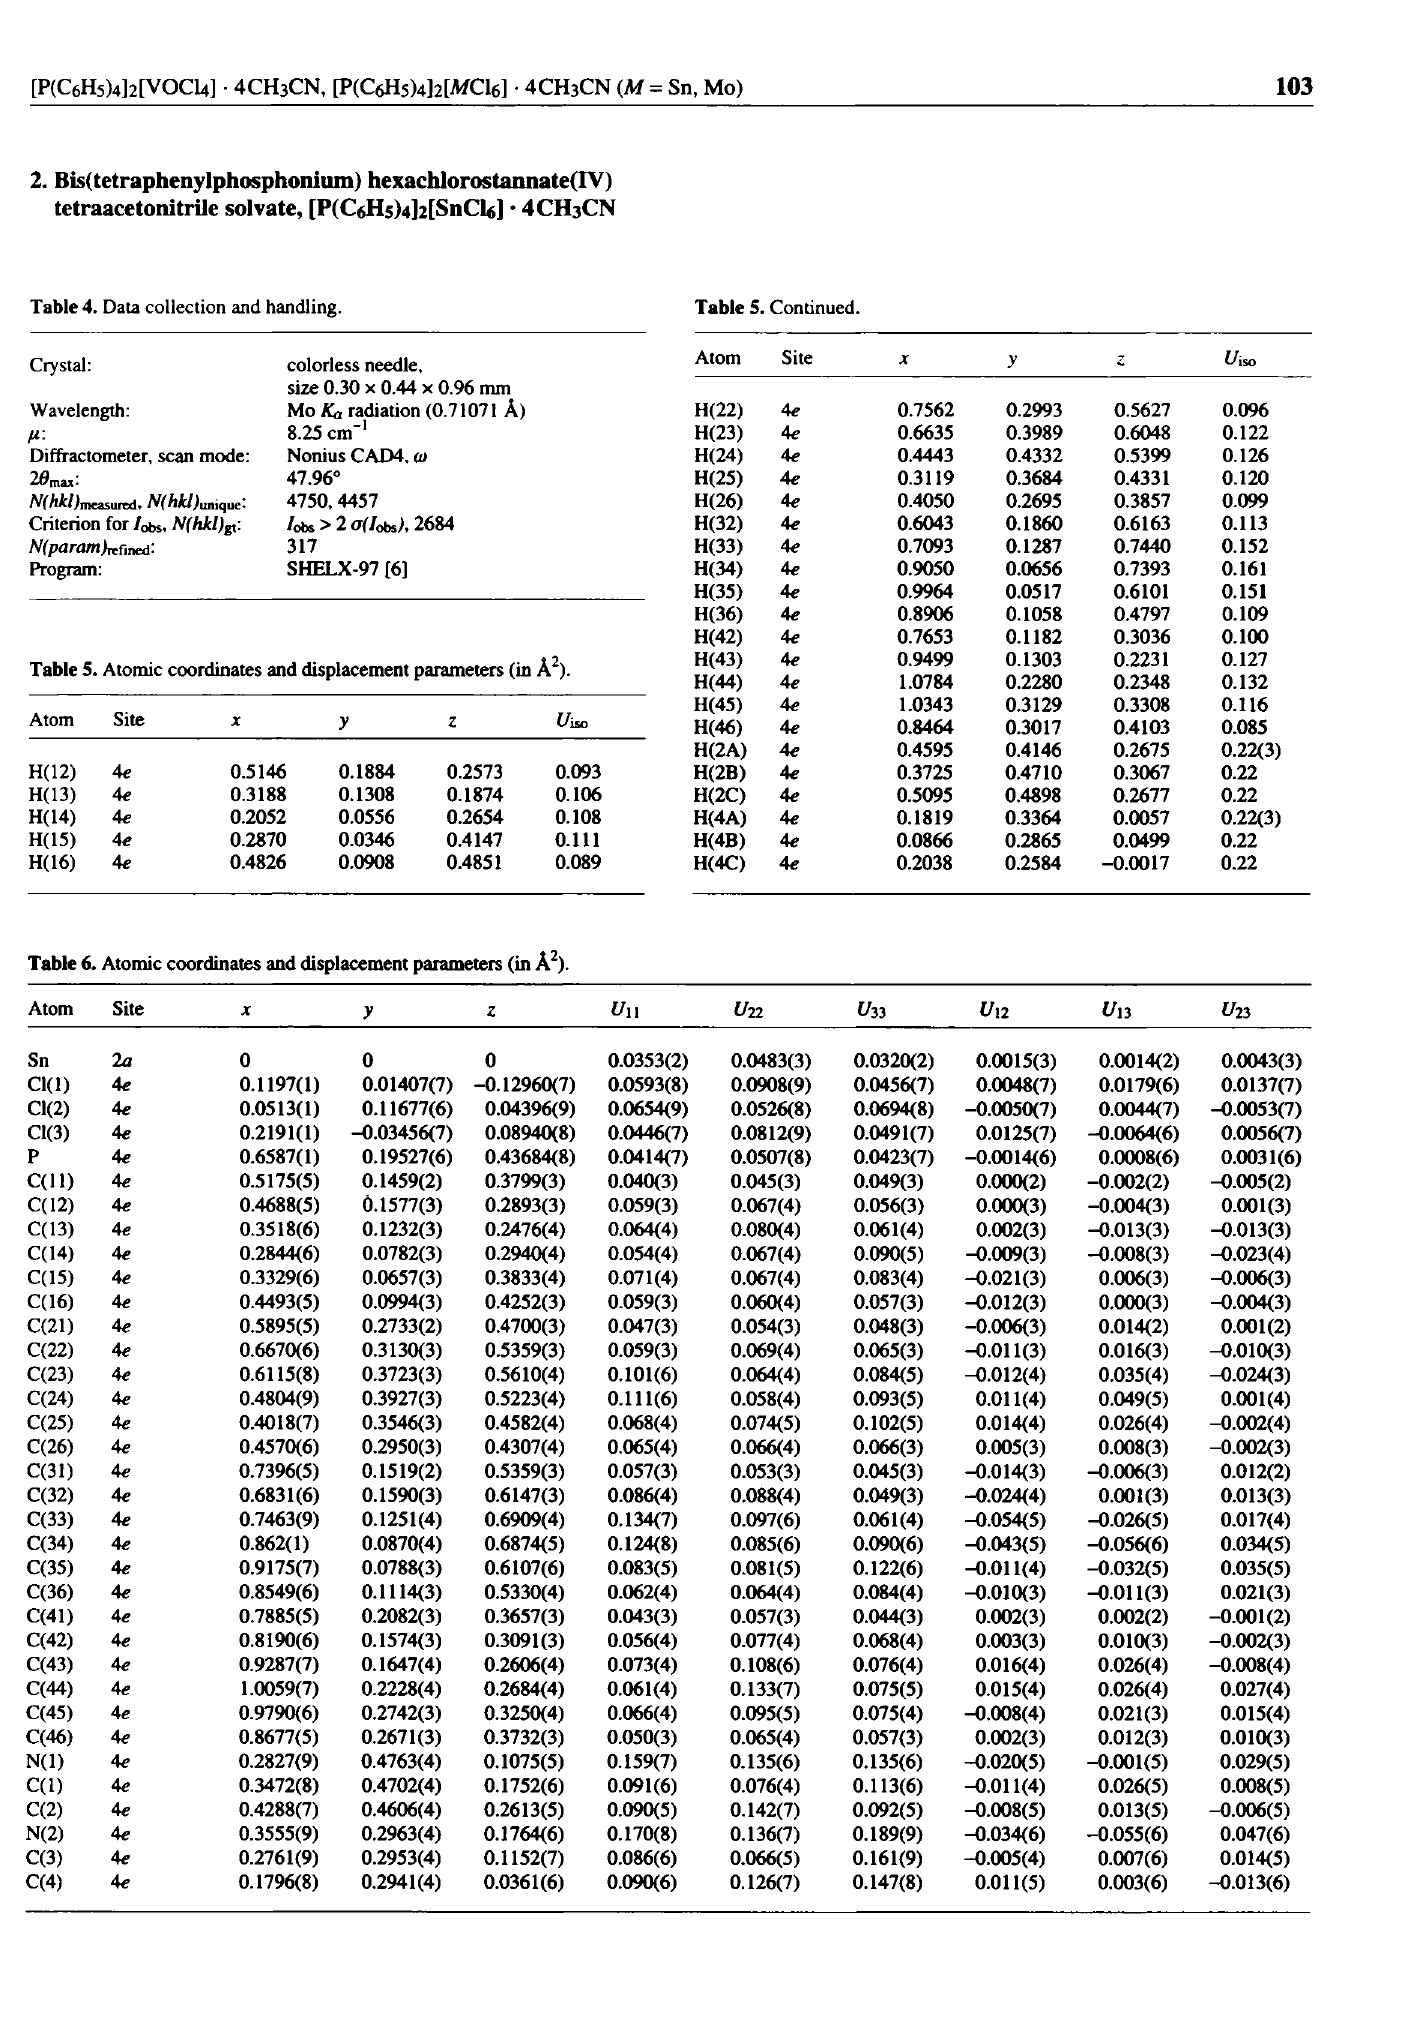
Table 5. Atomic coordinates and displacement parameters (in Â 2 ).